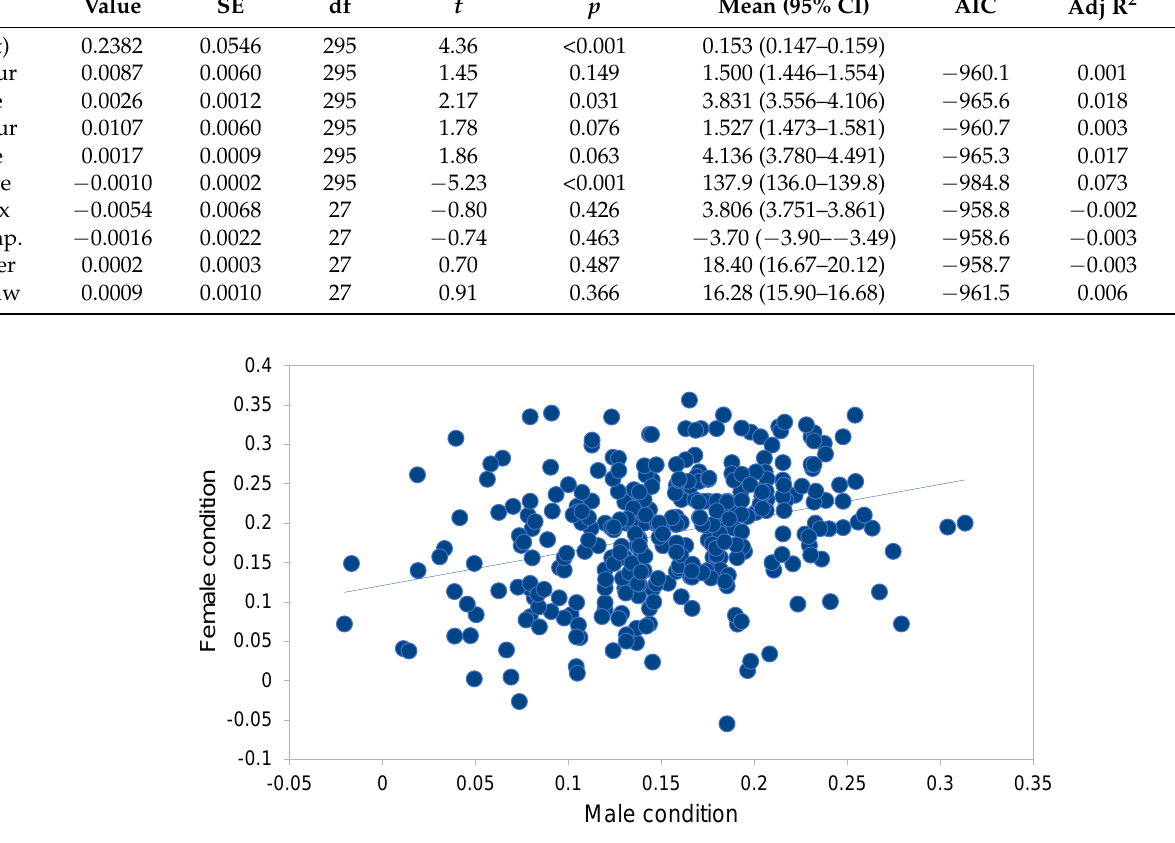
Figure 4. Relationship between Julian date and male body condition of breeding Tawny Owls Strix aluco in the studied population in southern Finland (f(x) = −0.001x + 0.275, r = −0.275, df = 330, p < 0.001).